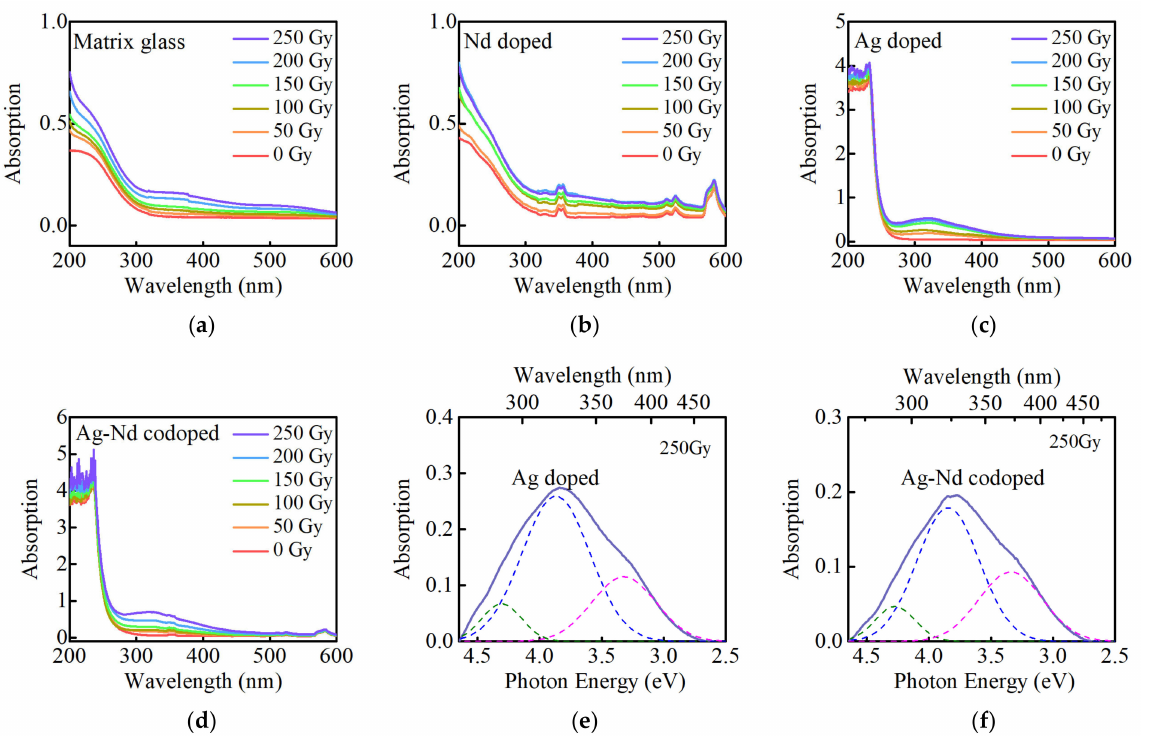
Figure 1. ( a ) The Absorption spectra of the matrix; ( b ) Nd-doped; ( c ) Ag-doped; ( d ) Ag–Nd-codoped glasses at various radiation doses; ( e ) Gaussian peaks for the induced absorption spectra of Ag-doped glass at 250 Gy; ( f ) Gaussian peaks for the induced absorption spectra of Ag–Nd-codoped glass at 250